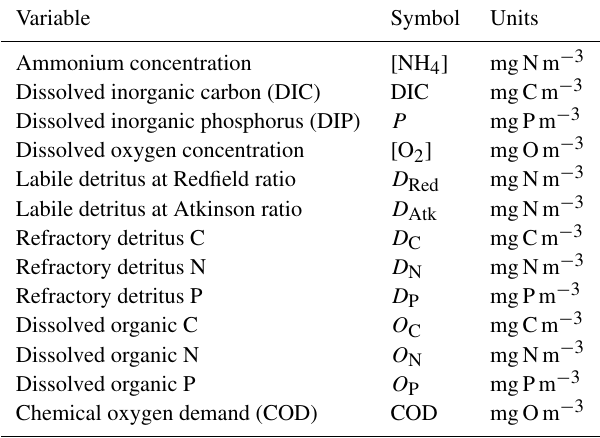
Table 37. State and derived variables for the detritus remineralisa- tion model in both the sediment and water